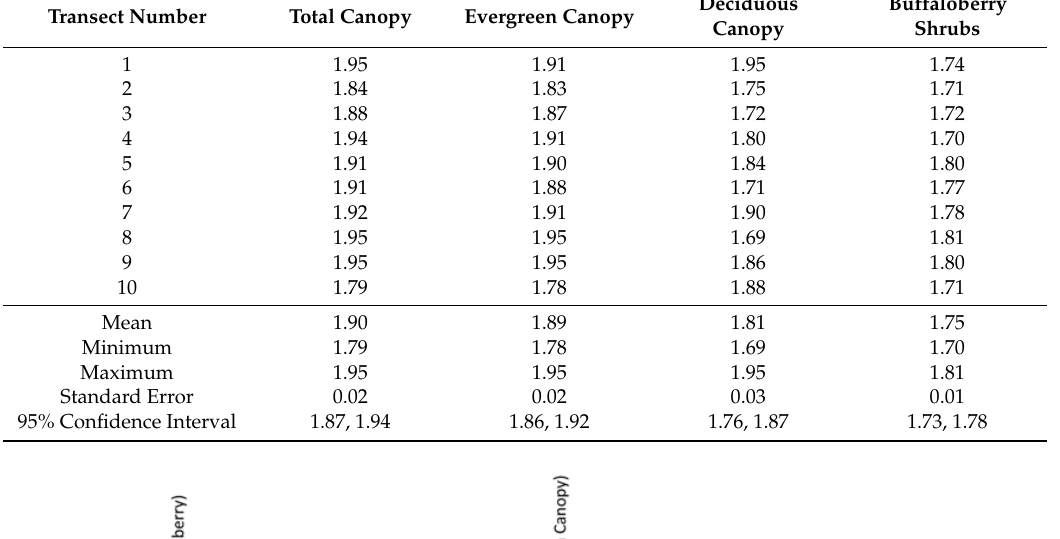
Table 3. Fractal dimensions of buffaloberry shrubs and forest canopy categories for each transect.